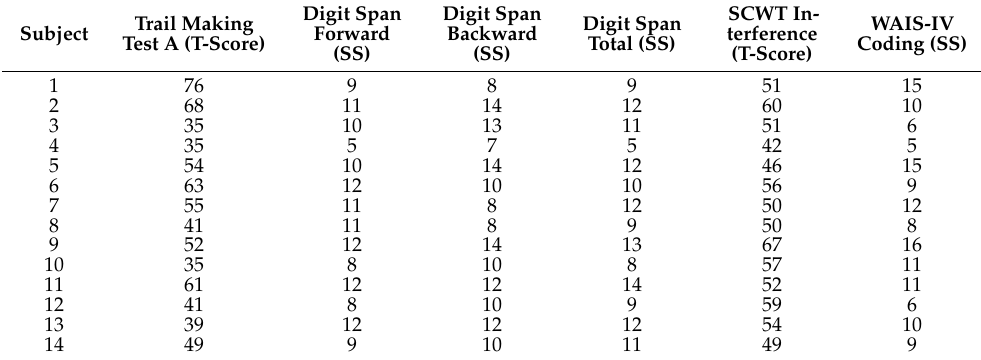
Table 3. Neuropsychological assessment scaled or T -scores *.